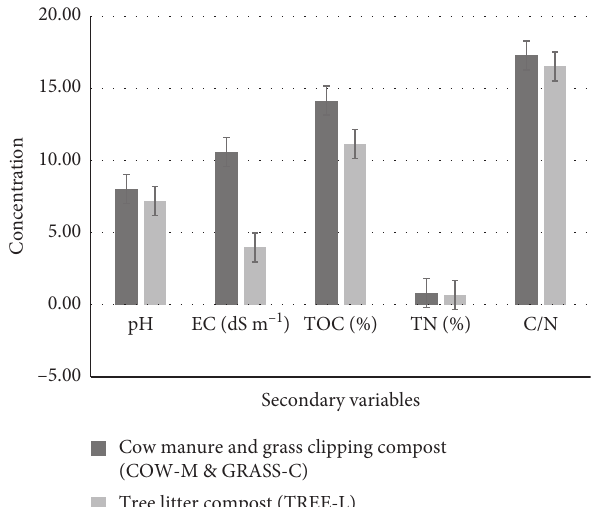
Figure 3: Mean values of physicochemical variables of cow manure and grass clipping compost, and tree litter compost ( n � 3).